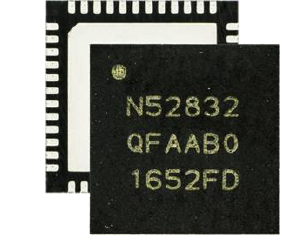
Figure 4. nRF52832 chipset